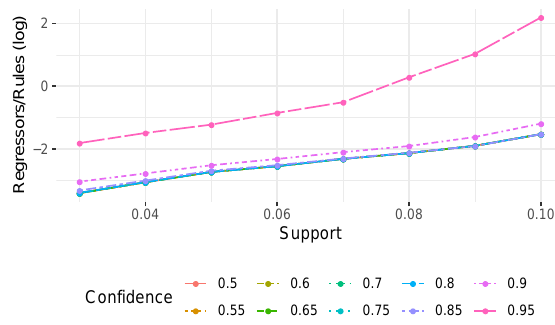
Figure 11. Fraction of obtained regressors per rule.